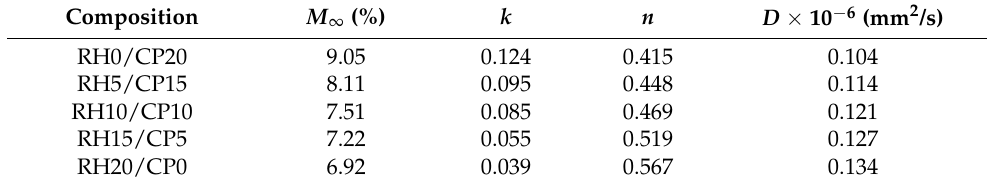
Table 2. Saturation water absorption, water absorption constant, swelling exponent constant, and diffusion coefficient of RH/CP reinforced ABS